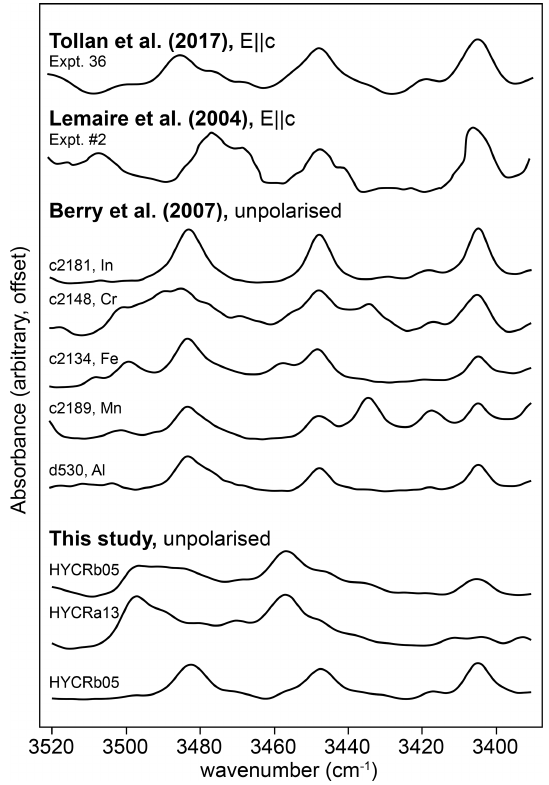
Figure 13. The 3390–3520cm − 1 region of the FTIR spectra from three interface measurements, along with the same region from sev- eral published spectra. See Fig. 6 of Tollan et al. (2017), Fig. 4 of Berry et al. (2007) and Fig. 3 of Lemaire et al. (2004) for the origi- nal